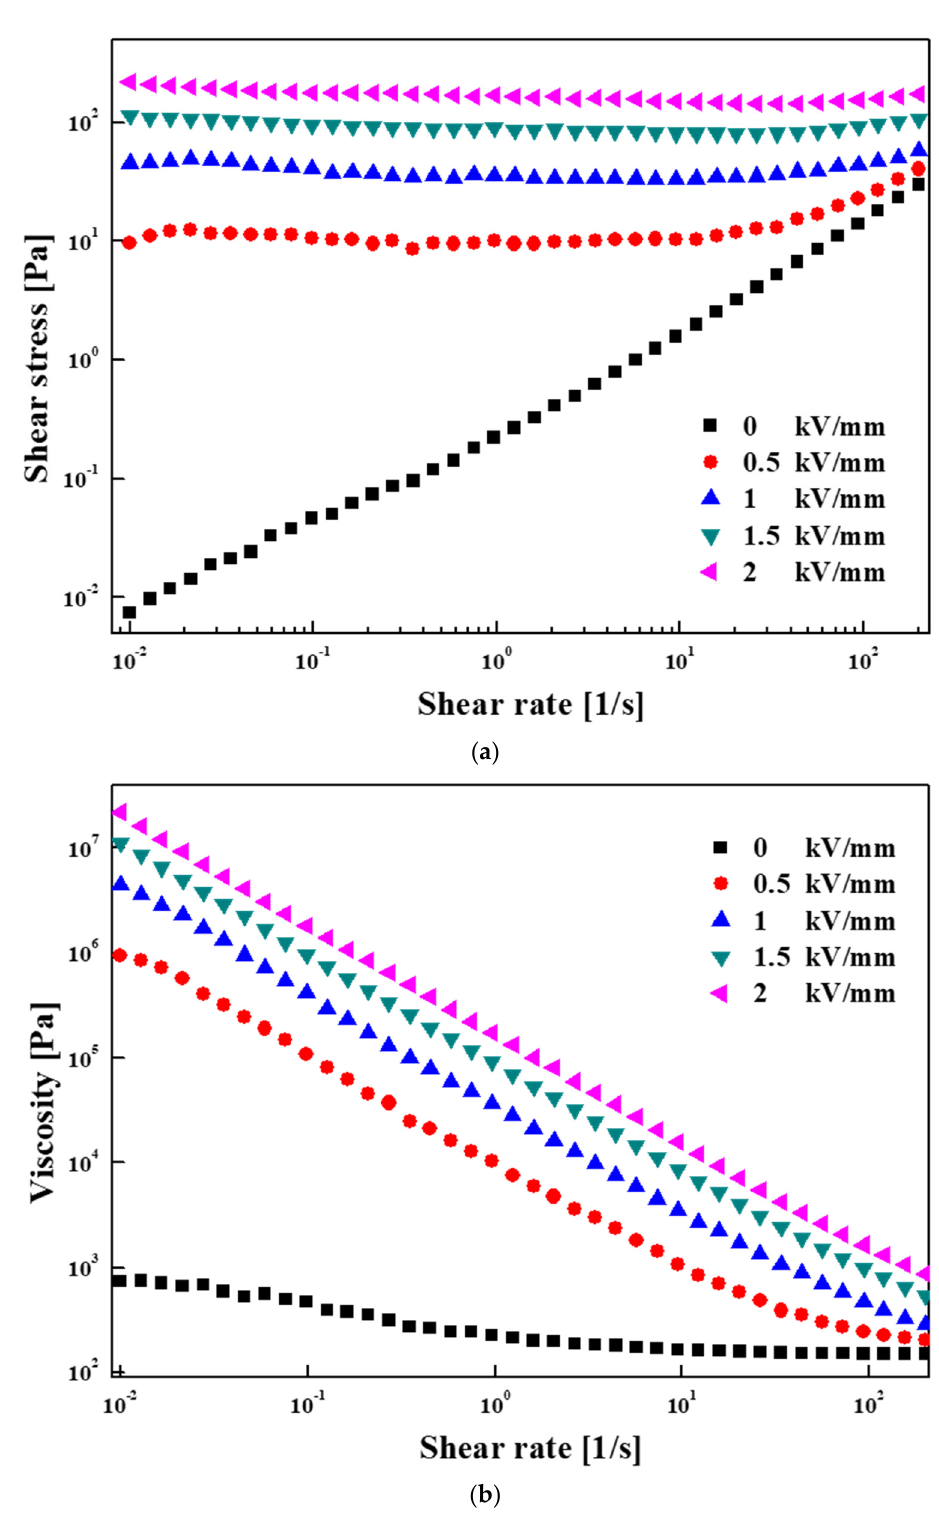
Figure 6. ( a ) Shear stress and ( b ) shear viscosity for core–shell Fe 3 O 4 /POA particle (10 vol%)-based ER suspension under different E s. The viscoelastic behavior of the Fe 3 O 4 /POA-based ER suspension was analyzed by measuring the storage modulus ( G ′ ) and loss modulus ( G ″ ) through dynamic oscillatory tests. The evaluation of the behaviors of ER fluids at sufficiently low oscillating strain am-